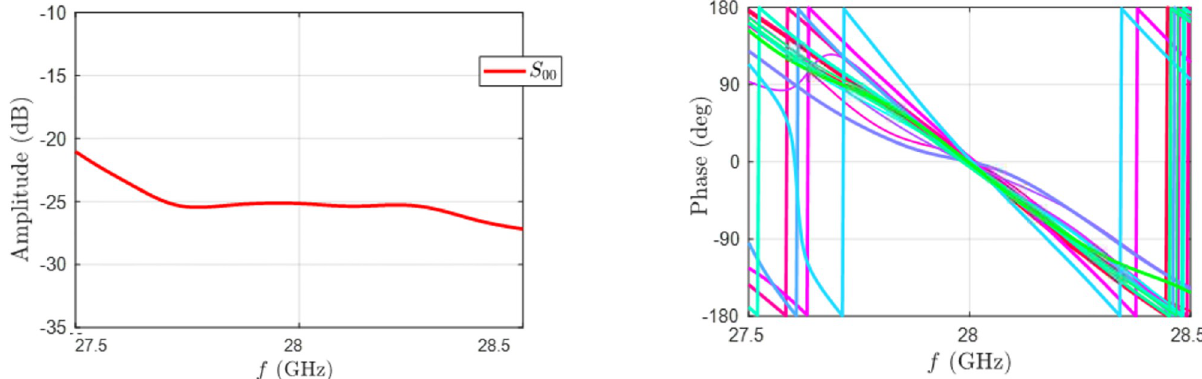
Fig 8. (a) The scattering parameter’s amplitude is less than -22dB, indicating the impedance matching (b) The comparison of the phase profiles of the 16 excitation ports with respect to the input port.